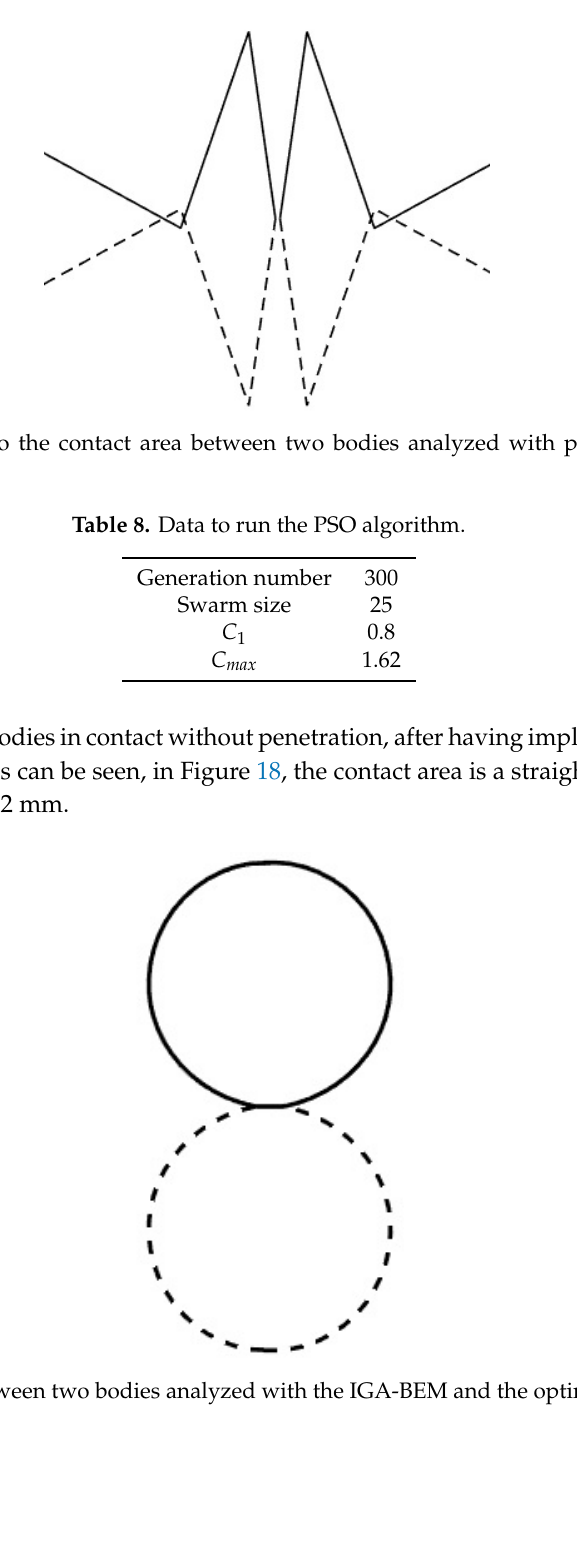
Figure 18. Close-up to the contact area between two bodies analyzed with the IGA-BEM and the optimization proposed.